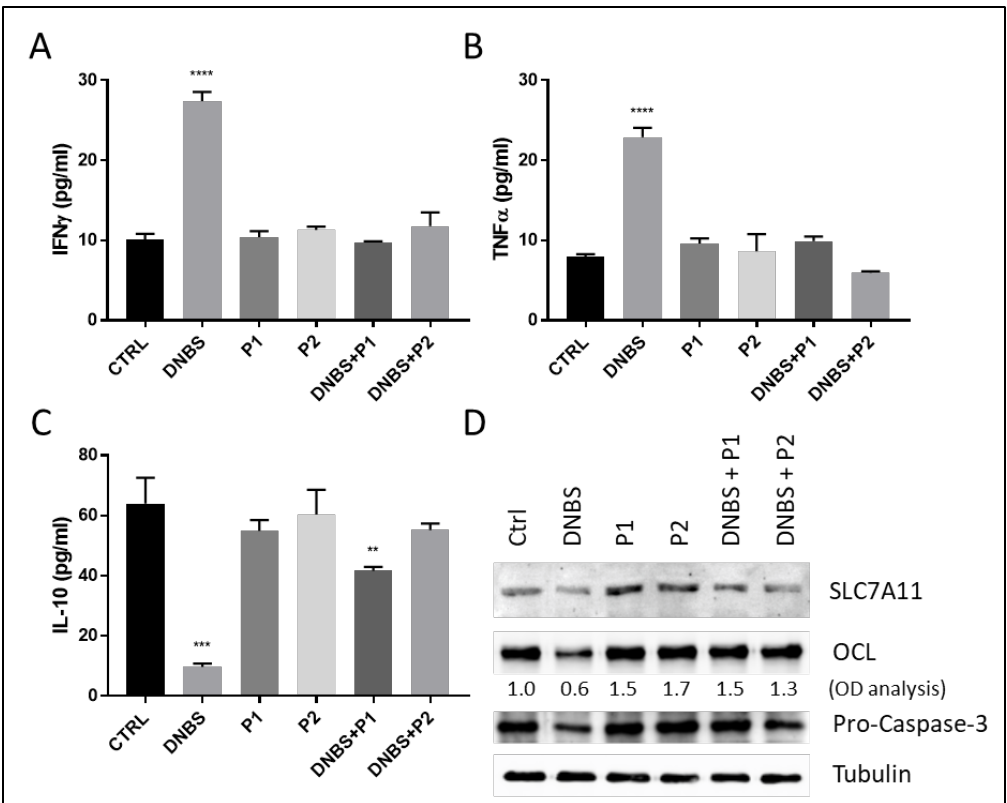
Figure 7. Impact of probiotics on DNBS-stimulated UC. Colon from C57BL/6 mice was untreated (CTRL) or exposed to DNBS (1.5 mg/mL), P1 or P2 alone or DNBS+P1 or DNBS+P2 for 5 h, in GEVS. The expression of the pro-inflammatory cytokines IFNg ( A ) and TNFa ( B ) or the anti-inflammatory IL-10 ( C ) was evaluated by ELISA on tissue lysates. ( D ) Protein levels of SLC7A11, OCL or pro-Caspase-3 was evaluated by western blotting analysis. Histograms represent mean ± SD of triplicate sample; **** p < 0.0001; *** p < 0.001; ** p < 0.01. Tubulin was used as loading